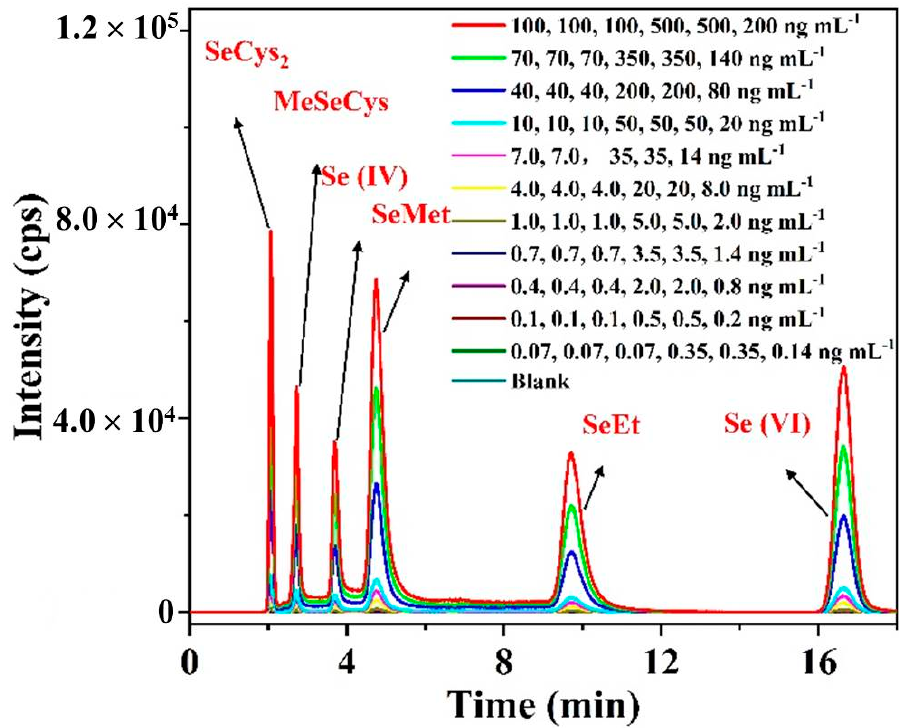
Figure 4. Chromatograms of the standard curves of six selenium species (Hamilton PRP-X100 column; 25 µ L injected; mobile phase conditions: 2% methanol, 25 mM Sodium citrate, pH = 4.0, flow rate of 1.0 mL min − 1 ). Table 2. Analytical characteristics of the proposed method.